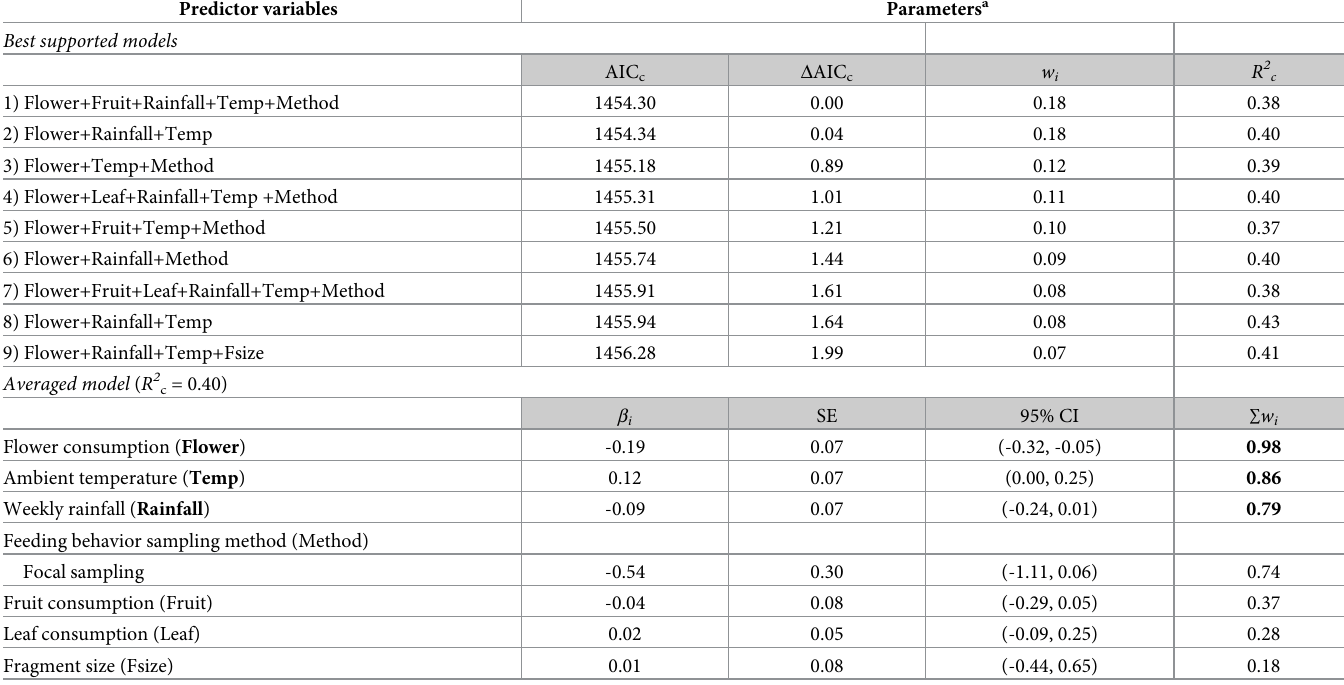
Table 2. Best supported GLMM models ( Δ AICc < 2) and model-averaged that predict the variation in the number of drinking records in 14 brown howler groups in southern Brazil. Predictor